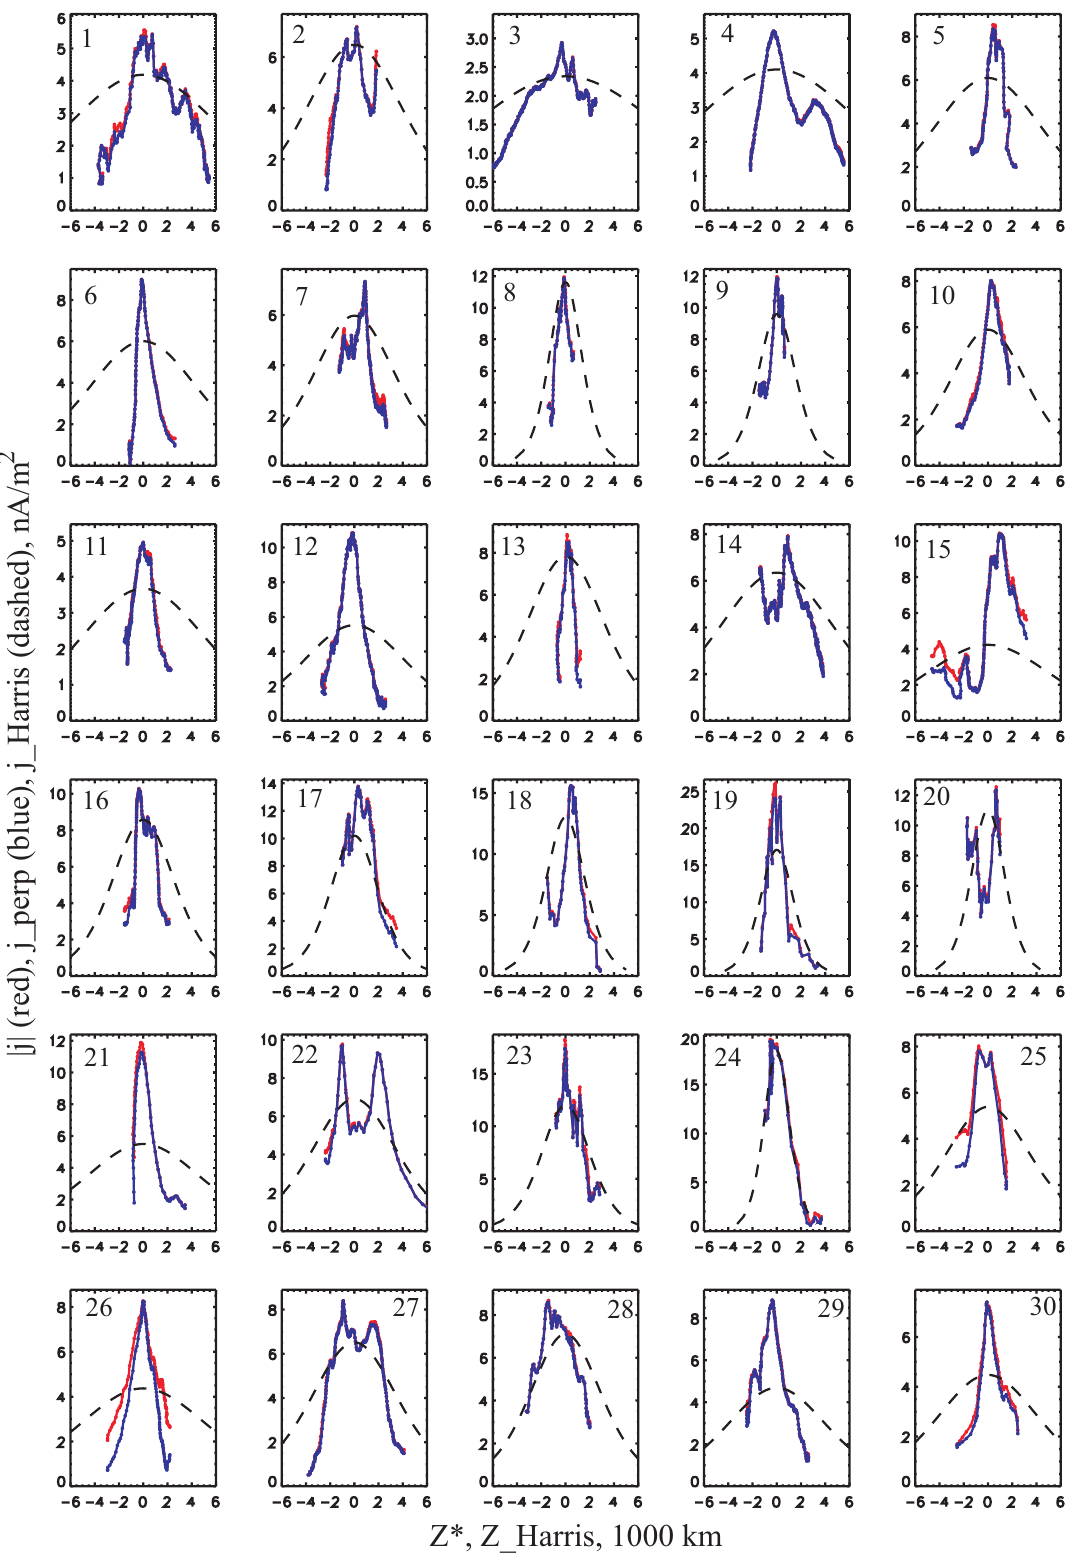
Fig. 3. Profiles of absolute values of the current densities j (blue) and j ⊥ (red) versus the effective vertical coordinate Z ∗ , calculated from Eq. (3). Dashed lines show the corresponding Harris